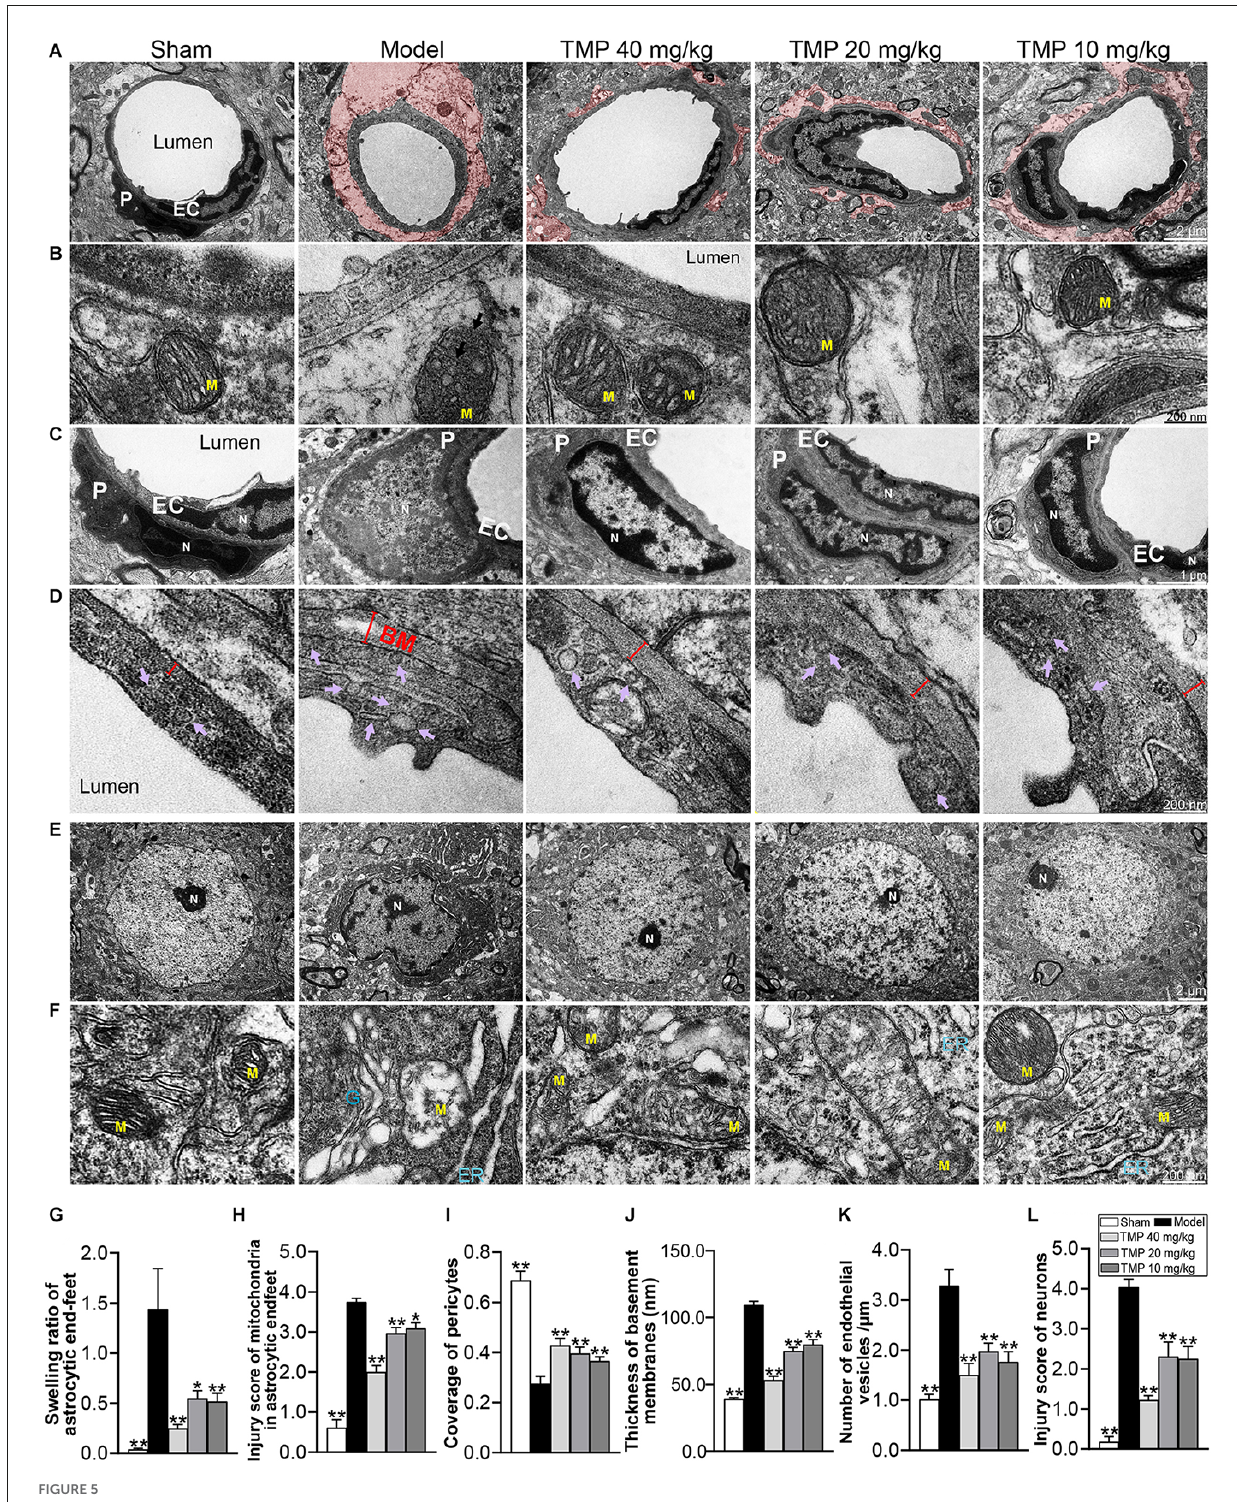
FIGURE5 TMP ameliorated the ultrastructural injuries of NVU in perilesional cortex of MCAO rats. (A) Typical microvascular images showed the morphology of endothelial cells (EC), pericytes (P), and circumvascular astrocytes ( n = 2). The swollen astrocytic endfeet were shaded in red. (B) Mitochondria (M) in astrocytic endfeet appeared the disintegrating cristae in the Model group. (C) Pericytes in microvessels were swollen and disintegrated from endothelial cells, and cell nuclei (N) showed heterogeneity, thickened nuclear membranes and irregular boundaries in the Model group. (D) Basement membranes (BM, red double-headed arrows) were thickened and caveolae-like vesicles (purple arrows) in endothelial cells increased in the Model group. (E) Typical neuronal images showed that circumvascular neurons and (F) circumambient organelle including mitochondria (M), endoplasmic reticulum (ER), and Golgi apparatus (G) were badly damaged in Model group. Quantification of (G) swelling ratio of astrocytic endfeet, (H) injury score of mitochondria in astrocytic endfeet, (I) coverage of pericytes to endothelial cells, (J) basement membrane thickness, (K) number of vesicles in endothelial cells/ µ m and (L) injury score of neurons. * P < 0.05, ** P < 0.01 vs. Model